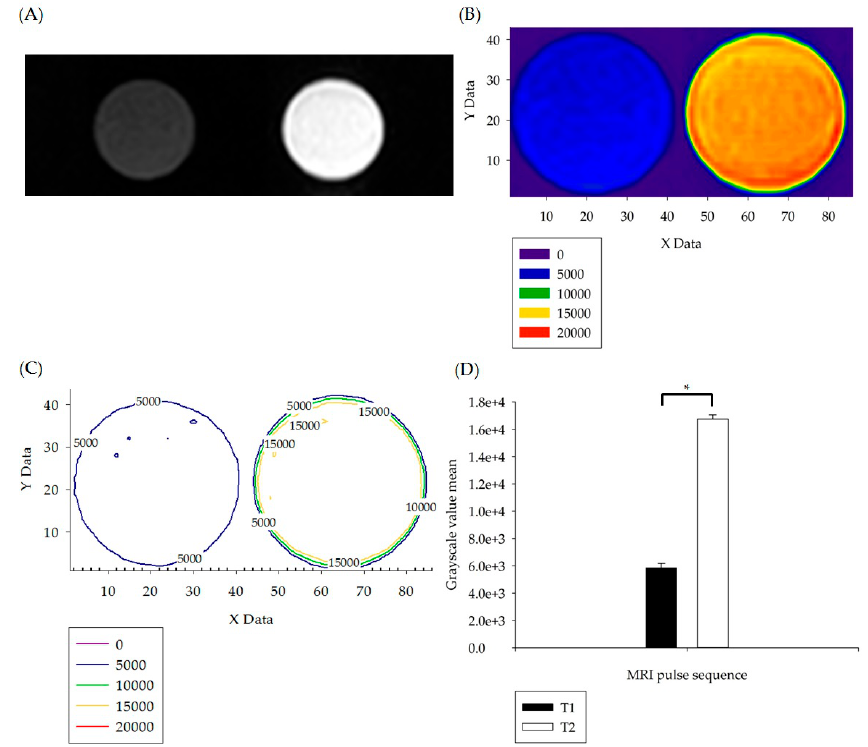
Figure 1. ( A ) T1W (dark) and T2W (bright) pulse sequence imaging was carried out with D.D. water as the sample. ( B ) The images in Figure 1A were subjected to grayscale image visualization color gradation, and the lower left corner of Figure 1B is the grayscale value color distribution table of each image. ( C ) The layered numerical information in Figure 1B was converted into a graphic numerical visual diagram. ( D ) Statistical analysis and comparison were carried out on the numerical information in Figure 1C. The p values less than 0.05 are summarized with one asterisk. Grayscale value visual matrix image color layer analysis was carried out on the DICOM grayscale images, and statistical analysis was performed by one-way ANOVA.